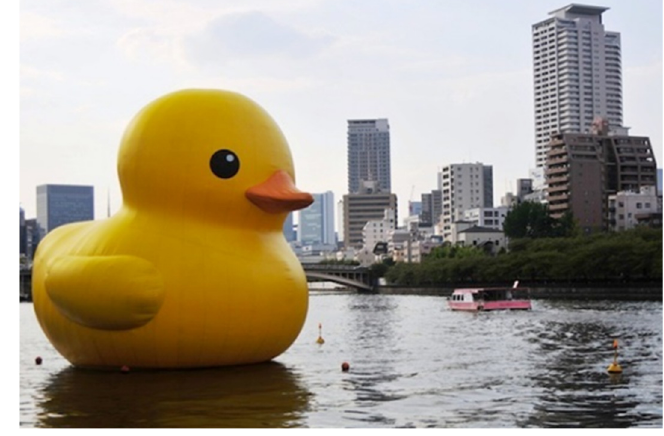
Figure 3. Public artwork “Rubber Duck”.